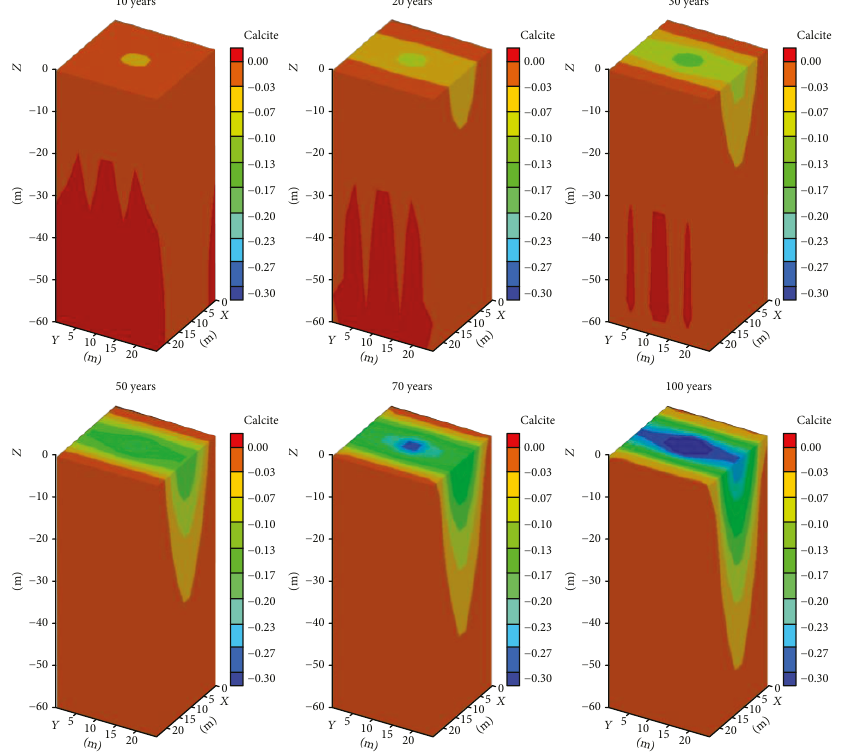
Figure 9: The corrosion range of the fi ssure under medium hydrodynamic conditions-medium permeability — 35 ° C.